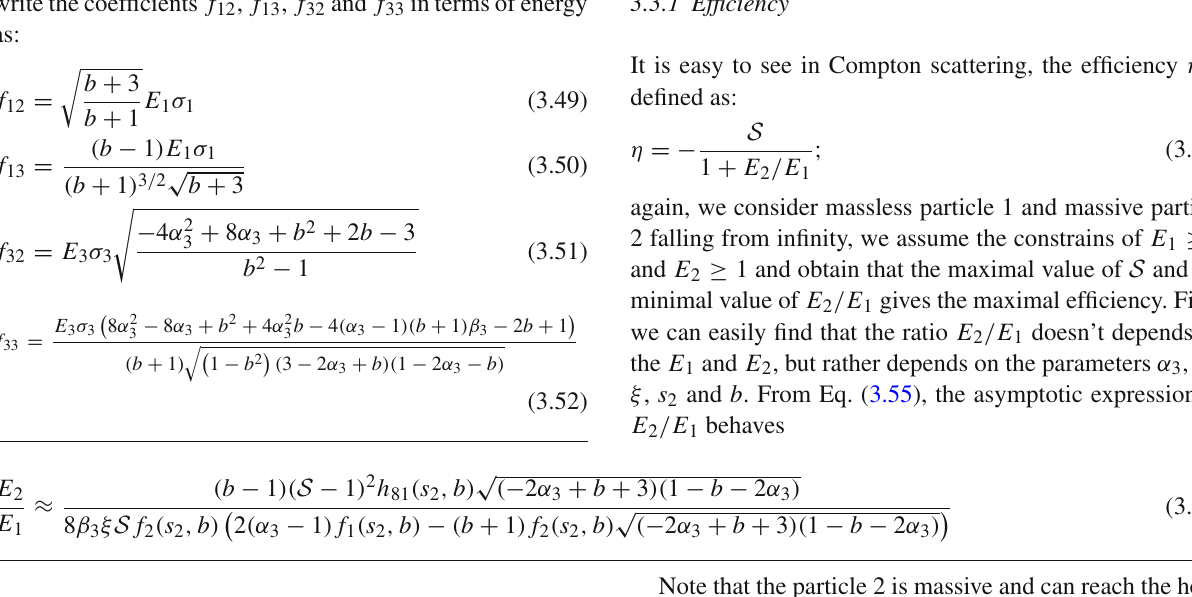
Fig. 7 The contour map of S in terms of α 3 and s 2 for different val- ues of b . The maximum value of E 3 is labeled by the red point. a When b = 0, η max = S max ≈ 26 . 8564 with s 2 = − 0 . 2679; b when